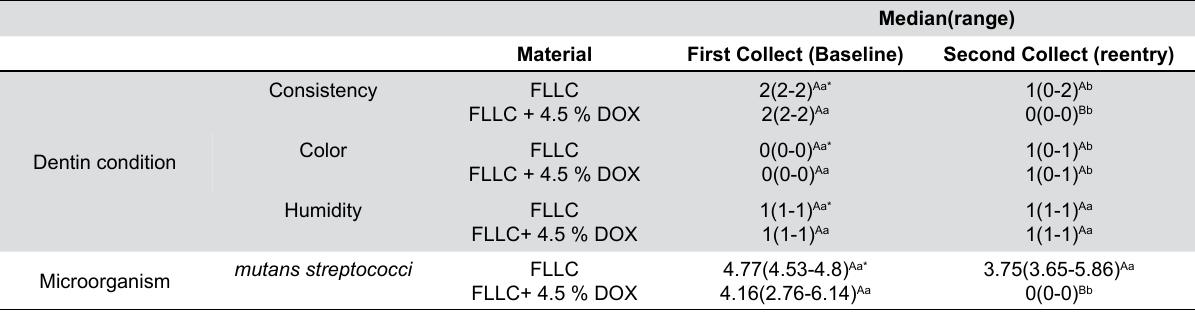
Table 2- Median and range (minimum-maximum) of clinical scores determined at baseline and reentry (after 3 months) of partial caries removal